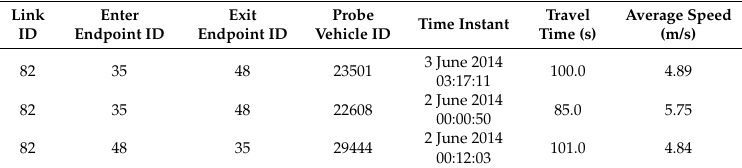
Table 5. Travel information from individual probe vehicles.